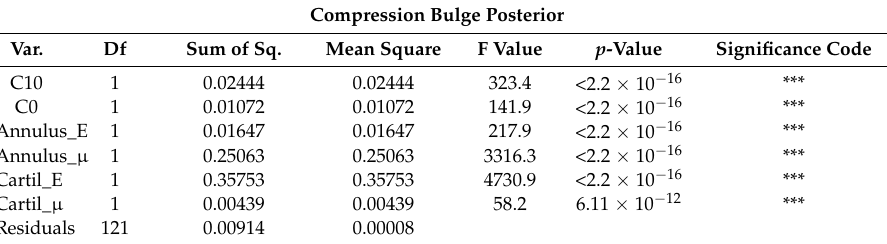
Table 13. ANOVA table for a compression bulge posterior linear model.